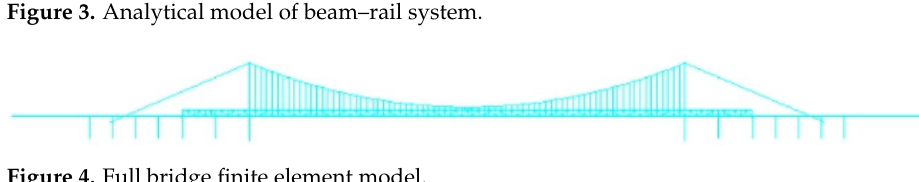
Figure 4. Full bridge finite element model.